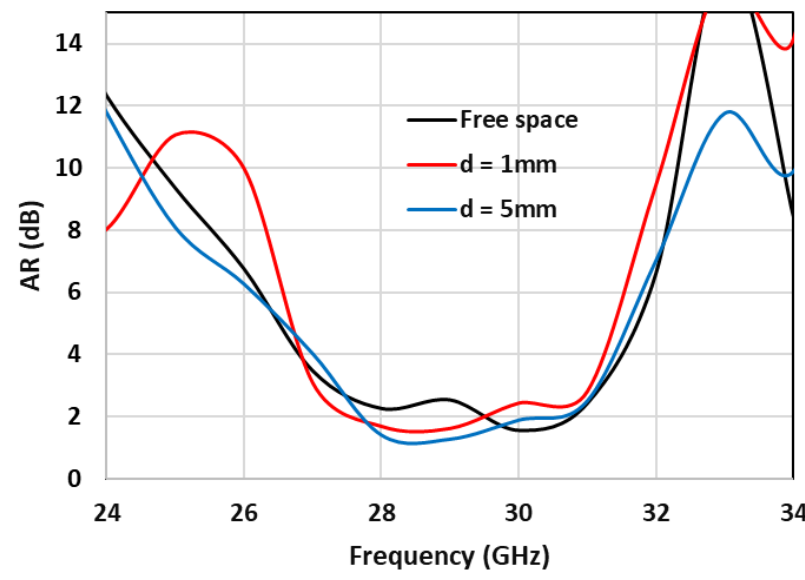
Figure 12. Axial ratio of a DRA array placed in free space and next to a body phantom.